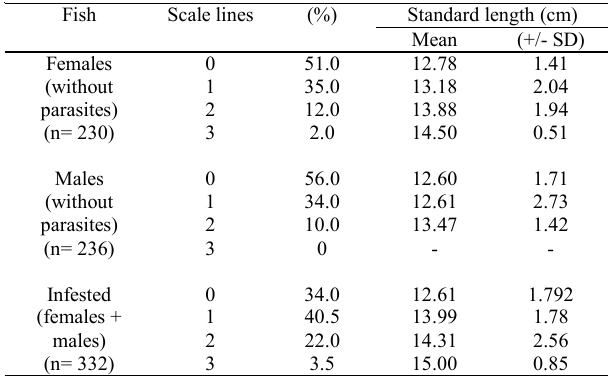
Table 1. Frequency of individuals (%) for each class of